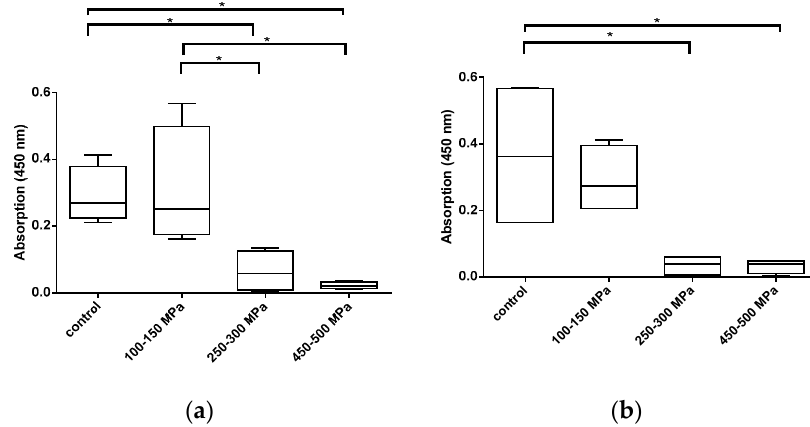
Figure 1. Metabolic activity of ( a ) human osteoblasts ( n = 4) and ( b ) human chondrocytes ( n = 4) following treatment with different HHPs ranging from 100–150 MPa, 250–300 MPa, and 450–500 MPa. After HHP exposure, cells were incubated at 37 °C and 5% CO 2 over a period of 24 h. Subsequently, metabolic activity was determined with water-soluble tetrazolium salt (WST-) 1 assay. Data are presented as boxplots. Significant differences between stimulation groups were determined via one-way ANOVA: * p ≤ 0.05.